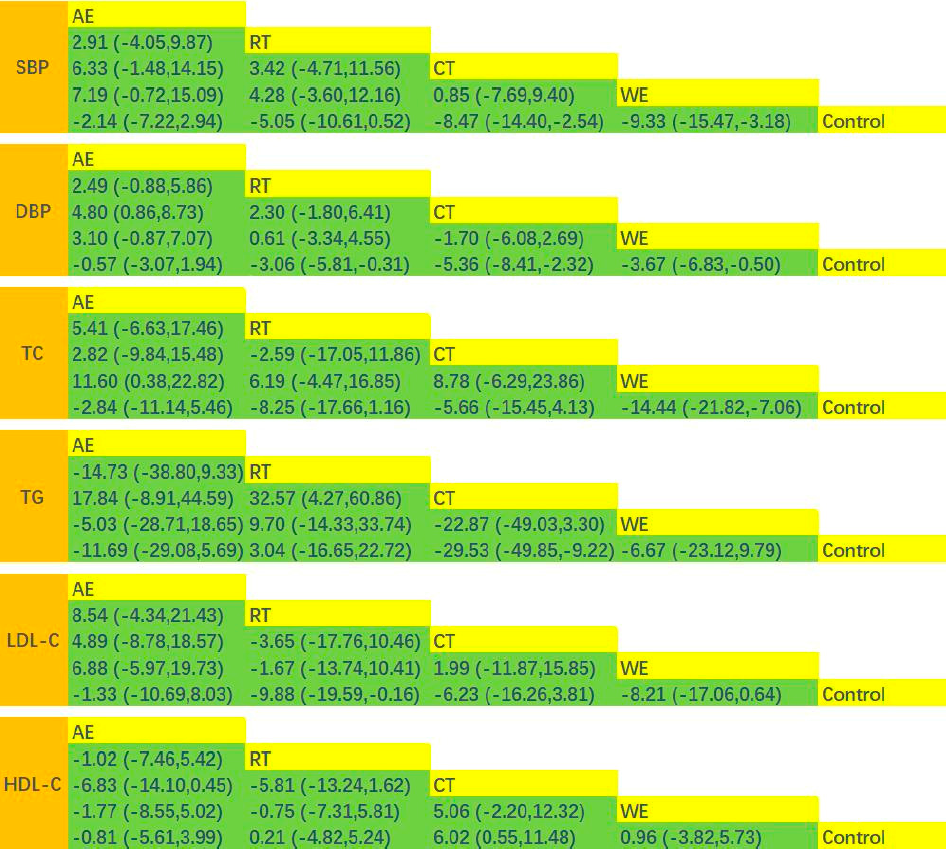
Figure 3. Matrix of the network meta-analysis results. AE, aerobic exercise; RT, resistance training; CT, combined training; WE, water exercise; CON, control group. Each cell shows the MD, along with the 95% CI.